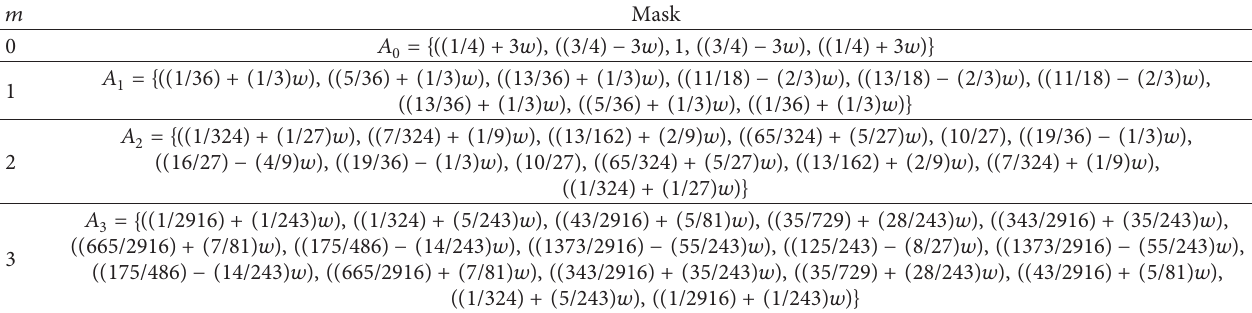
m . m corresponding to the different values of